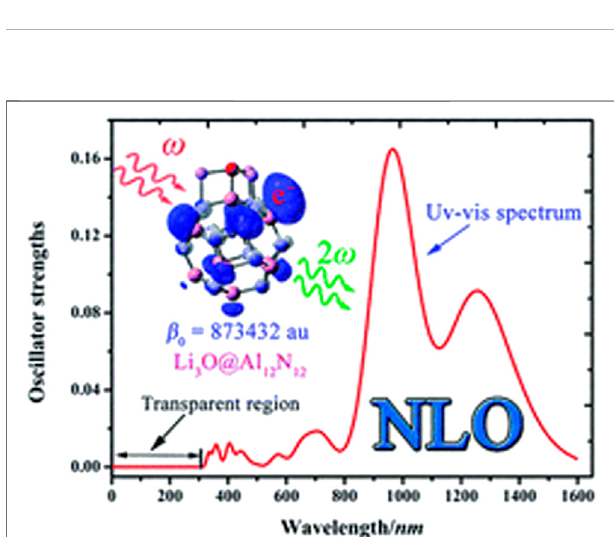
FIGURE 10 | Superalkali Li 3 O doped Al 12 N 12 nanocage with NLO response and UV-visible spectrum. Reprinted from W. M. Sun et al., 2016a with permission of Royal Society of